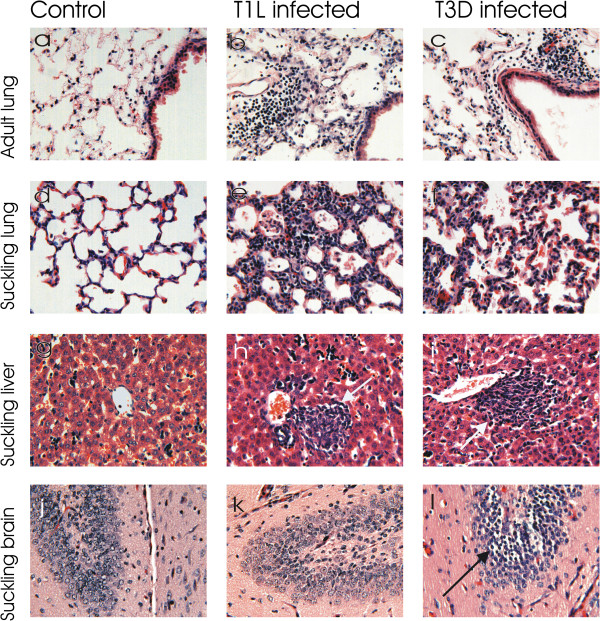
Pathology of virus infected lung, liver and brain tissues. Adult or 2 day old suckling mice were infected intranasaly with 107 or 105 pfu respectively with either T1L or T3D before sectioning formalin fixed, paraffin embedded sections for histopathological assessment by H and E. staining. Panels a, d, g, and j show uninfected control images for adult or suckling lung, liver and brain sections of mice as labeled. Panels b, e, h, and k show the T1L infected lung, liver and brain of the indicated types (suckling or adult) of infected mouse organs. Panels c, f, i, and l show the T3D infected lung, liver and brain for the indicated types (suckling or adult) of mouse organs. Arrows show local areas of cellular damage in liver and suckling brain sections that show the dentate gyrus of the hippocampus. Lungs and liver were imaged 7 days pi and brains at 13 days pi. Images were captured with the 20X objective.